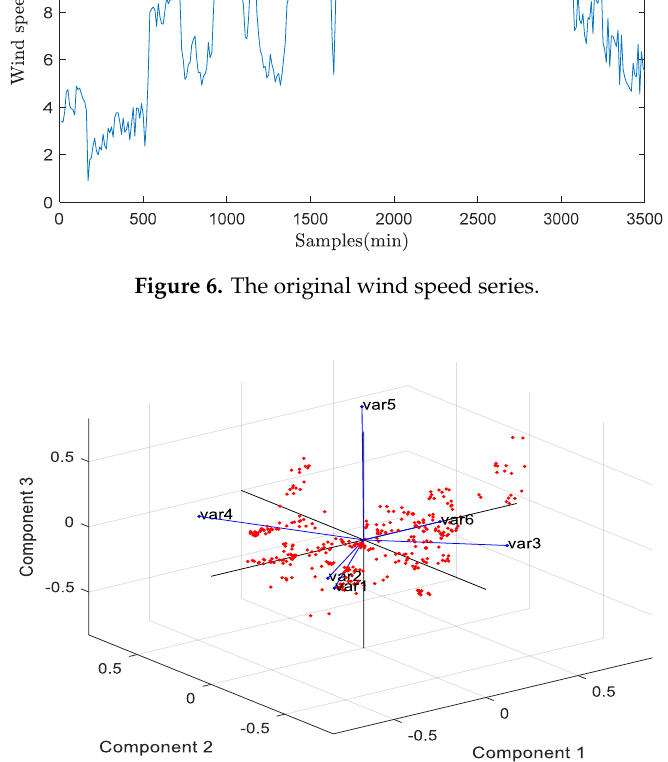
Figure 7. The visualization of principal component scores of each variable.